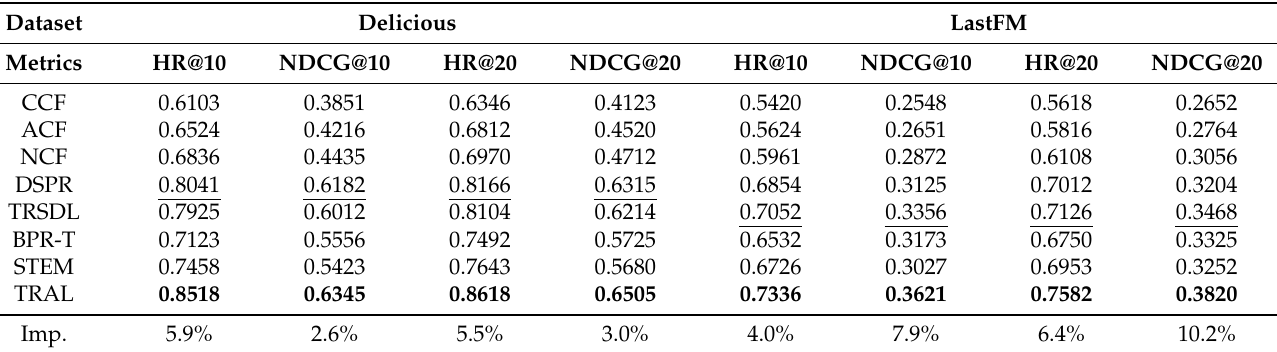
Table 3. Overall performance comparison on two datasets in terms of HR and NDCG metrics. Boldface represents the highest score and underline denotes the best result of the baselines. The improvement (imp.) of the proposed model compared to the best baseline is